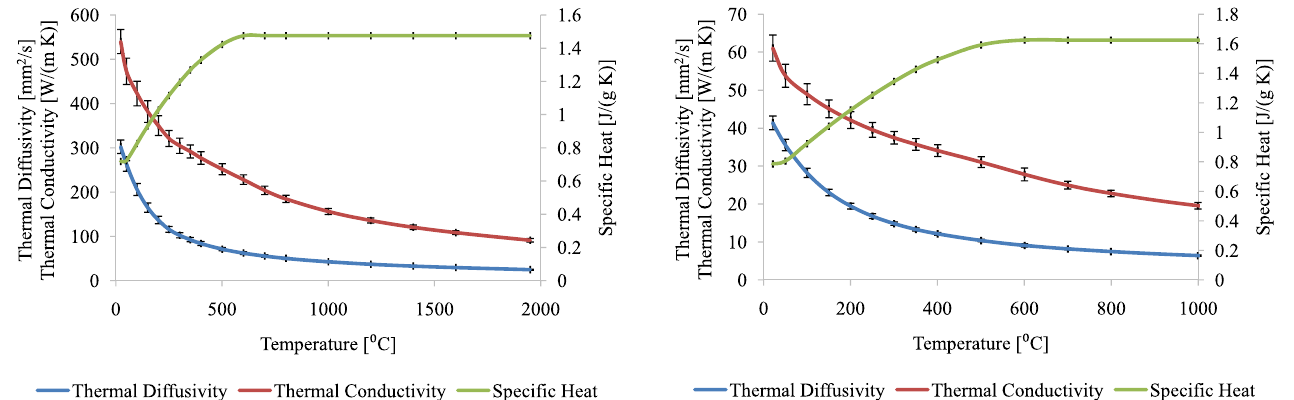
FIG. 8. Plot of thermal diffusivity, thermal conductivity, and specific heat against temperature for CFC ( T ).